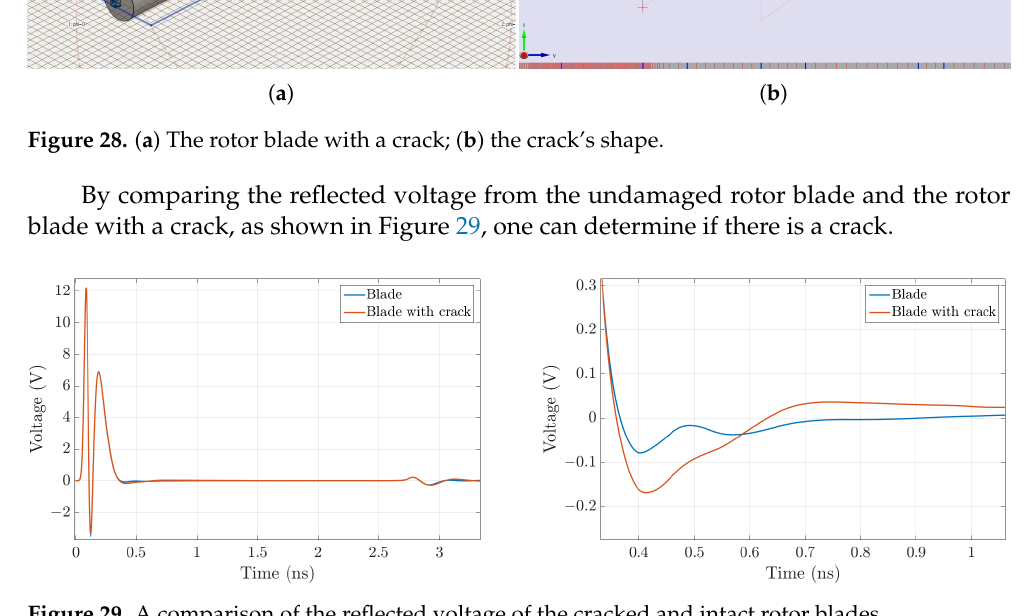
Figure 29. A comparison of the reflected voltage of the cracked and intact rotor blades. We will take into account two minor hidden cracks in the rotor blade in the final simulation of this work. According to Figure 30, the first crack is 5.505 cm in length and 0.632 cm in width, while the second crack measures 2.875 cm in length and 0.50 cm in width.